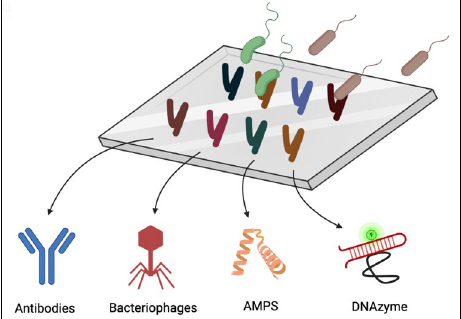
Figure 1. Schematic representation of the binding of bacteria to a surface that can be coated (or functionalized) with different molecules acting as ligands such as antibodies, bacteriophages, antimicrobial peptides (AMPs), or DNAzyme.